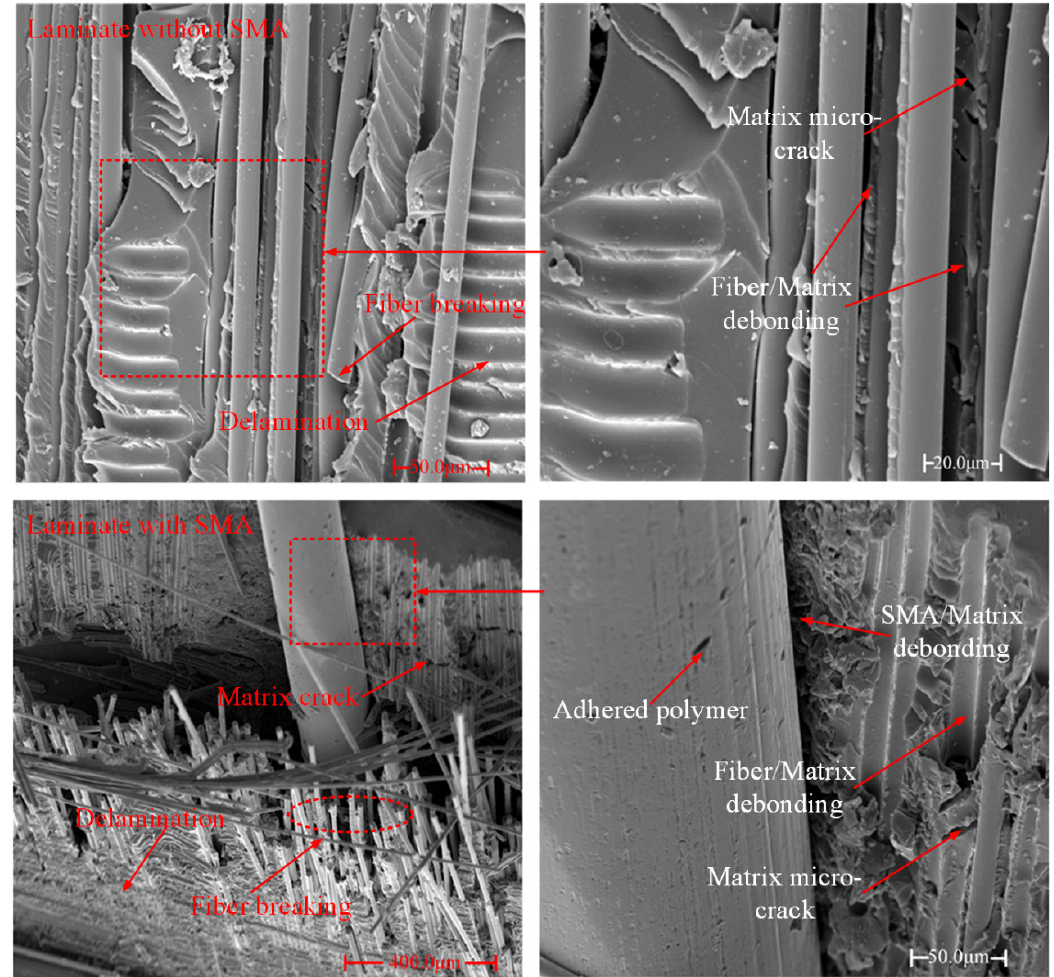
Figure 8. Typical damage morphology of the impacted laminates obtained by SEM.